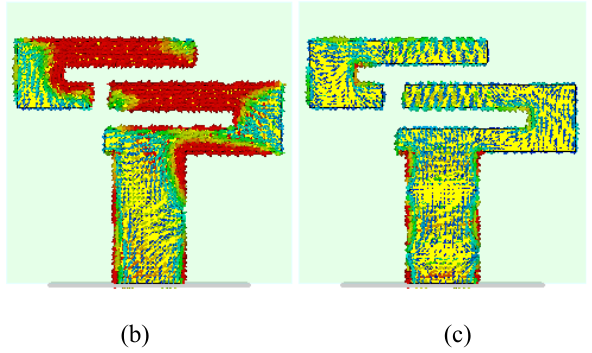
FIGURE 8. Surface current distribution of the proposed triple band antenna at 7.5 GHz (a), 9 GHz (b) and 28 GHz (c).